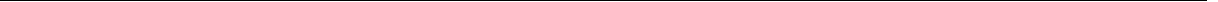
Fig. 3 Phenotypic diversi fi cation in TAQed yeast strains. a Phase contrast images of representative TAQed mutants. Scale, 10 µ m. b , c Heterogeneity in fl occulation phenotype in the TAQed strains (a fusion of YPH499 and S799). Images of hyper- fl occulation b and hypo- fl occulation c mutants at the indicated times after mixing. Control, non-TAQed strain. d Growth curves of xylose-utilizable haploid (W700M2), thermotolerant haploid (N44D), non- TAQed, and TAQed fused diploids (SNT17 and SNT11-2×40, respectively) in glucose-containing or xylose-containing media at 30 or 40 °C. Optical density at 600nm (OD 600 ) of each independent culture initiating from a low cell density (<OD = 0.001) was measured at every minute. We set the t = 0 point as OD 600 = 0.2 when cells undergo exponential growth. We plotted averages of each 10 min interval of three biological replicates along with standard deviations (vertical bars). Non-TAQed fused diploid cells grew faster with glucose at 40 °C than other strains, but did not with xylose at 40 °C. Only TAQed strain proliferates well in the presence of xylose at 40 °C. e Ethanol production in culture supernatant was measured after culturing in glucose- containing or xylose-containing media at 40 °C for 8, 24, and 48 h. The average of three individual replicates, error bars are ±